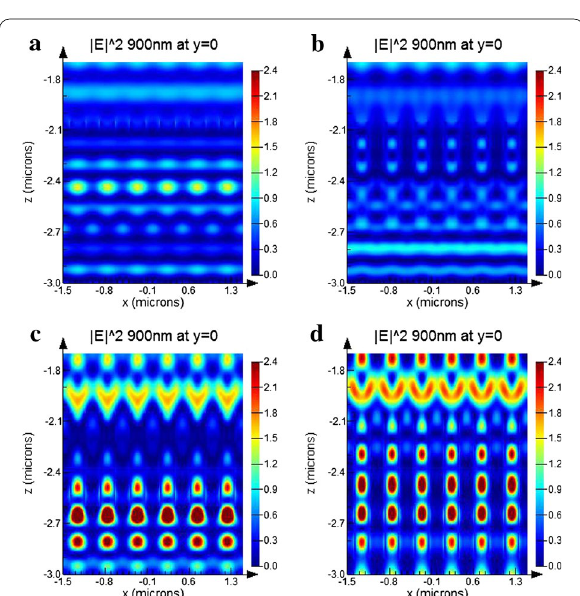
Fig. 6 Electric field intensity distribution at 900 nm of tandem solar cells with nanoholes array versus height a h 100 nm, b h 300 nm, = = c h 600 nm, d h 900 = =